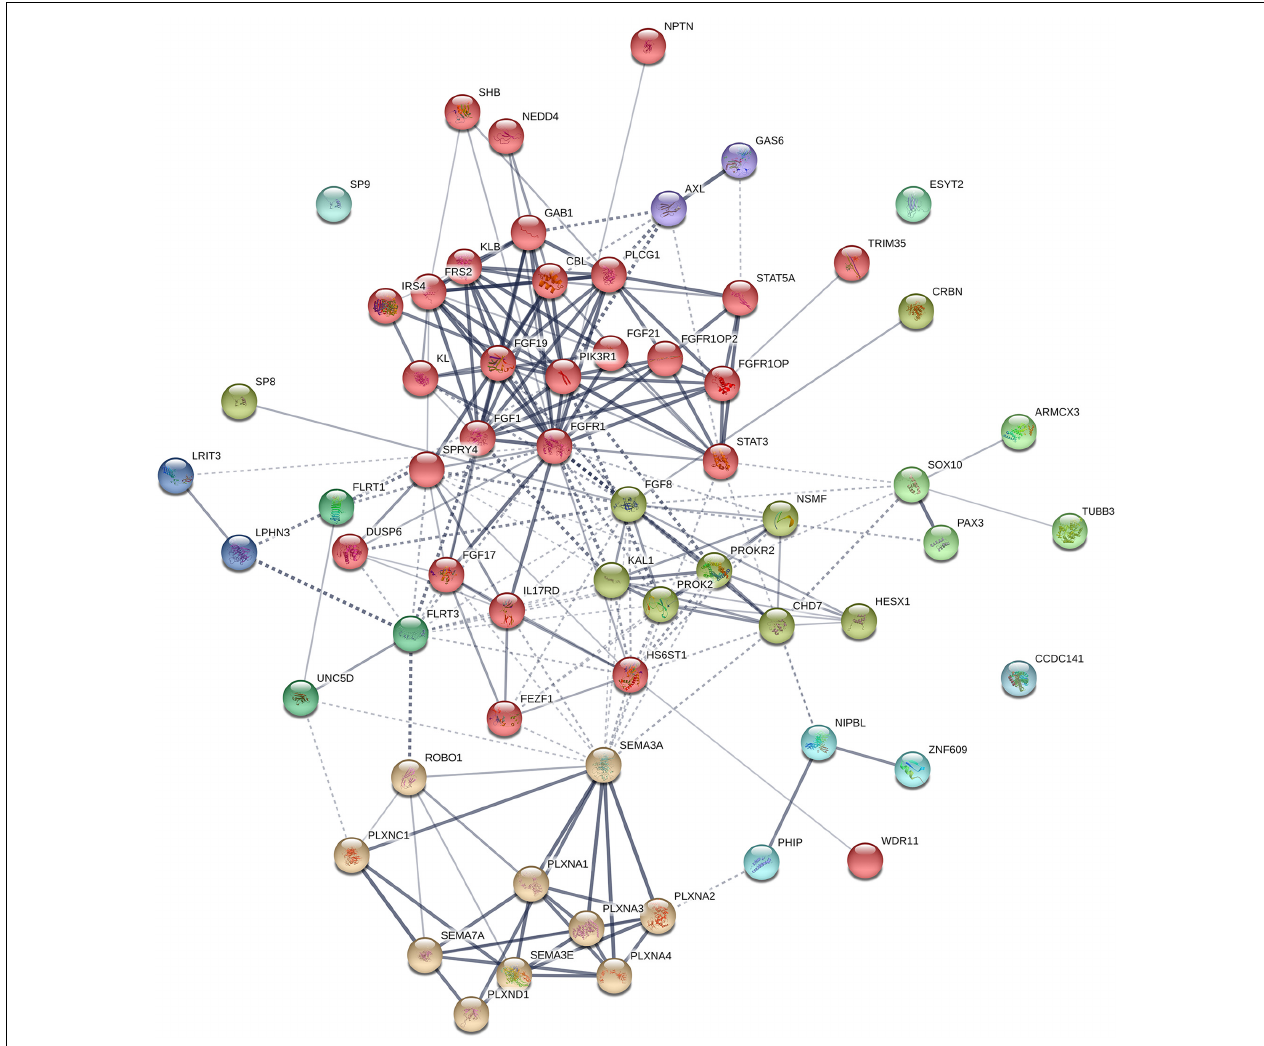
FIGURE 6 | Protein–protein interaction network in known genes of KS and their interacting partners. The diagram shows known and predicted interactions among KS causative genes and their interacting proteins, created using String software version 11.0 with minimal confidence score of 0.4. Total 227 lines (interactions) appear across 63 nodes (25 known factors of KS and 38 additional interacting proteins). The colored nodes symbolized proteins which clustered by MCL algorithm. The thickness of the line represents confidence of protein–protein associations. Solid line, interactions within a cluster; Dotted line, interactions between clusters. Abbreviations for 38 proteins interacting with known KS factors: ARMCX3, Armadillo repeat-containing X-linked protein 3; CBL, E3 ubiquitin-protein ligase CBL; CRBN, Protein cereblon; ESYT2, Extended synaptotagmin-2; FGF1, Fibroblast growth factor 1; FGF19, Fibroblast growth factor 19; FGF21, Fibroblast growth factor 21; FGFR1OP, FGFR1 oncogene partner; FGFR1OP2, FGFR1 oncogene partner 2; FLRT1, Leucine-rich repeat transmembrane protein FLRT1; FRS2, Fibroblast growth factor receptor substrate 2; GAB1, GRB2-associated-binding protein 1; GAS6, Growth arrest-specific protein 6; IRS4, Insulin receptor substrate 4; KL, Klotho; LPHN3, Adhesion G protein-coupled receptor L3; LRIT3, Leucine-rich repeat; NEDD4, E3 ubiquitin-protein ligase NEDD4; NIPBL, Nipped-B-like protein; NPTN, Neuroplastin; PAX3, Paired box protein Pax-3; PHIP, PH-interacting protein; PIK3R1, Phosphatidylinositol 3-kinase regulatory subunit alpha; PLCG1, 1-phosphatidylinositol 4,5-bisphosphate phosphodiesterase gamma-1; PLXNA2, Plexin-A2; PLXNA3, Plexin-A3; PLXNA4, Plexin-A4; PLXNC1, Plexin-C1; PLXND1, Plexin-D1; ROBO1, Roundabout homolog 1; SHB, SH2 domain-containing adapter protein B; SP8, Transcription factor Sp8; SP9, Transcription factor Sp9; STAT3, Signal transducer and activator of transcription 3; STAT5A, Signal transducer and activator of transcription 5A; TRIM35, Tripartite motif-containing protein 35; UNC5D, Netrin receptor UNC5D; ZNF609, Zinc finger protein 609.